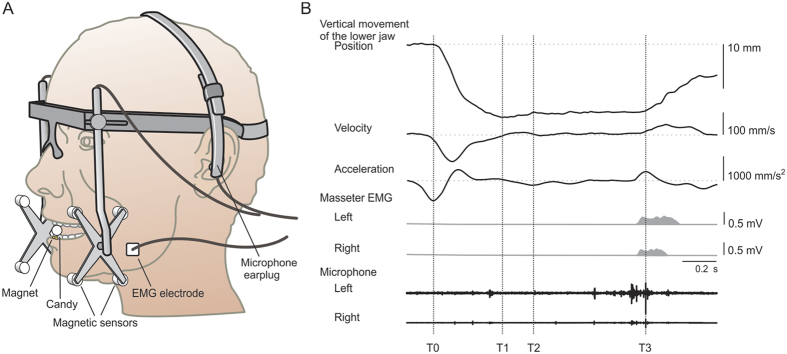
(A) The device custom built to monitor movement of the lower jaw relative to the upper jaw during different behavioral tasks. Magnetic sensors (four on each side) located on arms projecting down from the frame track the position of a magnet attached to the labial surface of the lower incisors. EMG activity was recorded bilaterally from the masseter muscles using bipolar surface electrodes. Sounds pertaining to crackling of the candy were recorded bilaterally by microphones secured in an earpiece on a headgear. (B) Representative recordings made during the “manipulation and split” task performed by a single participant. From top to bottom the curves depict: position; velocity and acceleration of the vertical movement of the jaw; muscle activity (the r.m.s.-processed EMG) from the left and right masseter muscles; and sound recordings from the left and right ear microphones. The events of interest are the following: The onset of the jaw opening phase (T0). End of the opening phase, and start of the contact-establishing phase (T1). End of the contact-establishing phase, and start of the contact phase (T2). End of the contact phase, and start of the jaw-closing phase (T3). The splitting of the candy was detected as rapid closing of the jaw that coincided with both a clear sound and increased EMG activity.